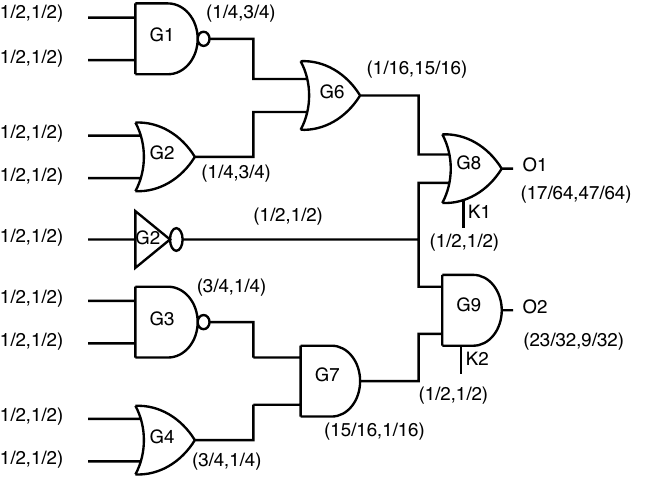
Figure 25. Output probability analysis using stack gates.